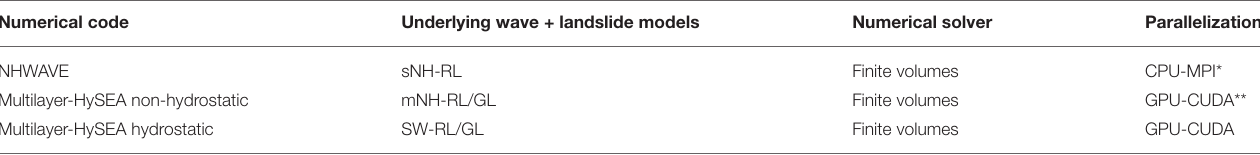
TABLE 3 | Numerical codes and modeling approaches tested in this